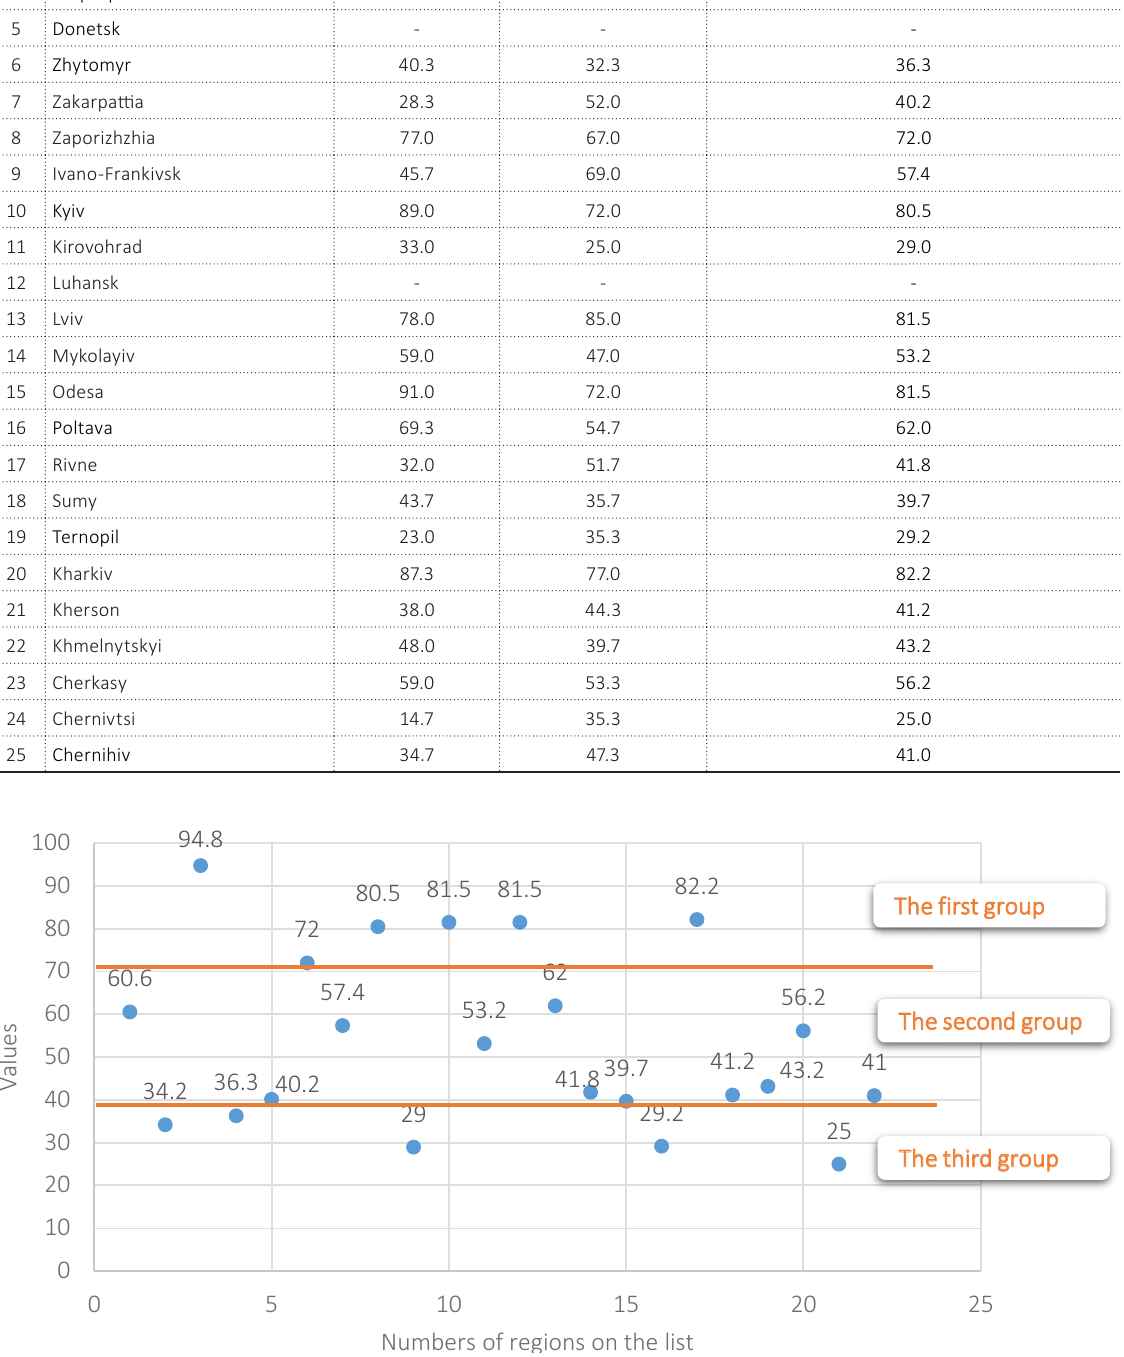
Figure 1. Grouping of Ukraine’s regions according to the integrated index of tourist